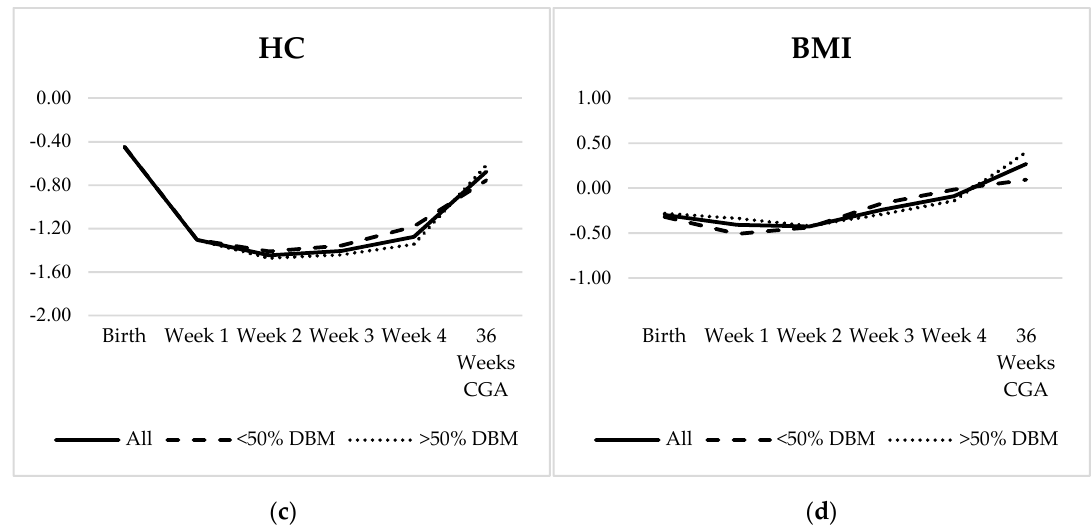
Figure 3. ( a – c ) Fenton z-score trajectories for weight, length, and head circumference (HC) and ( d ) Olsen z-score trajectory for body mass index (BMI) over time for all infants (solid line, n = 60), infants with <50% DBM intake (dashed line, n = 25), and infants with >50% DBM intake (dotted line, n = 35).